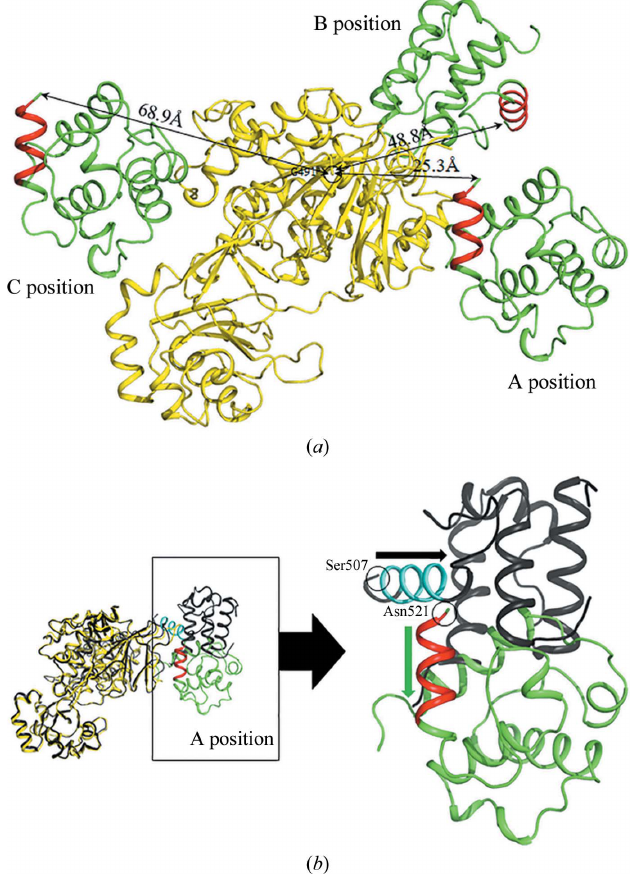
Figure 5 ( a ) Possible orientation of the CH domain in the asymmetric unit. We inferred that the interaction between the FMO and CH domains of human MICAL3 occurs in the A position. Straight lines indicate the shortest distance from the C-terminus of the FMO domain to the N-terminus of the CH domain. ( b ) Backflip of the CH domain of human MICAL3. Green and red indicate the CH domain and actin-binding helix of human MICAL3, respectively; black and cyan indicate the CH domain and actin-binding helix of mouse MICAL1, respectively. The green arrow indicates the direction from the N-terminus to the C-terminus of the human MICAL3 CH domain; the black arrow indicates the same direction for mouse MICAL1.